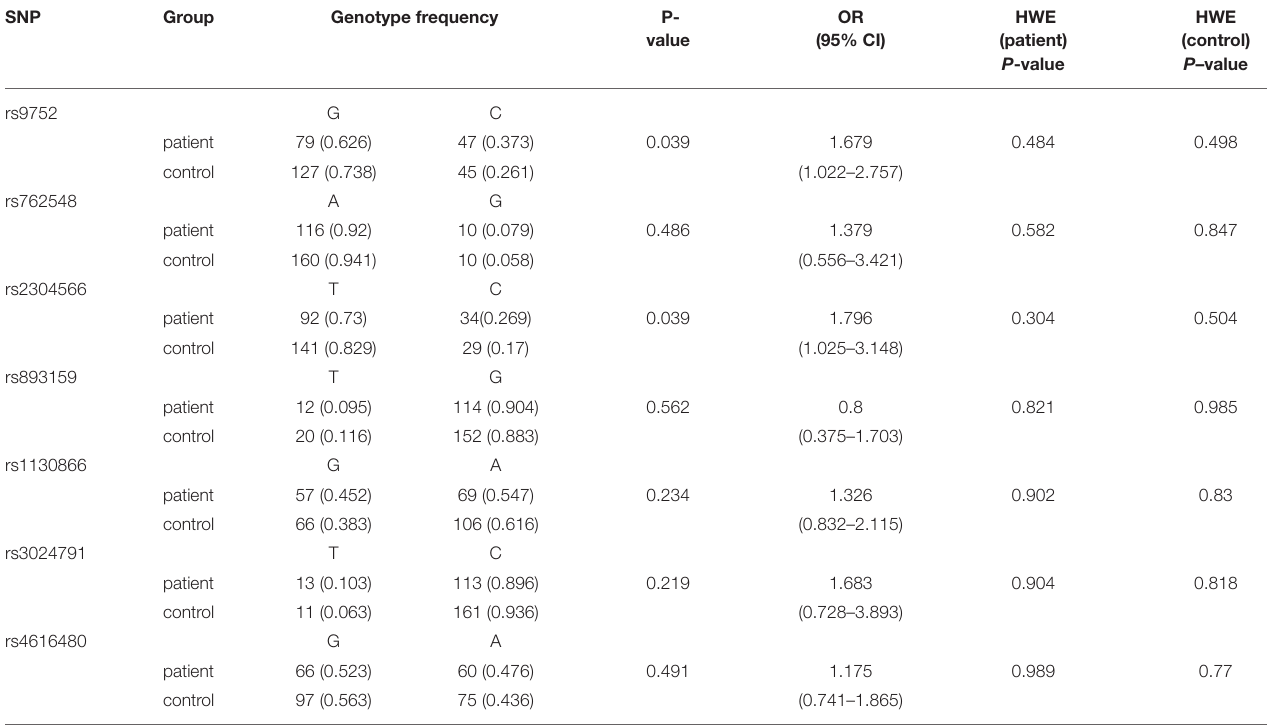
TABLE 4 | Distribution of individual genotypes in gene SFTPB . SNP